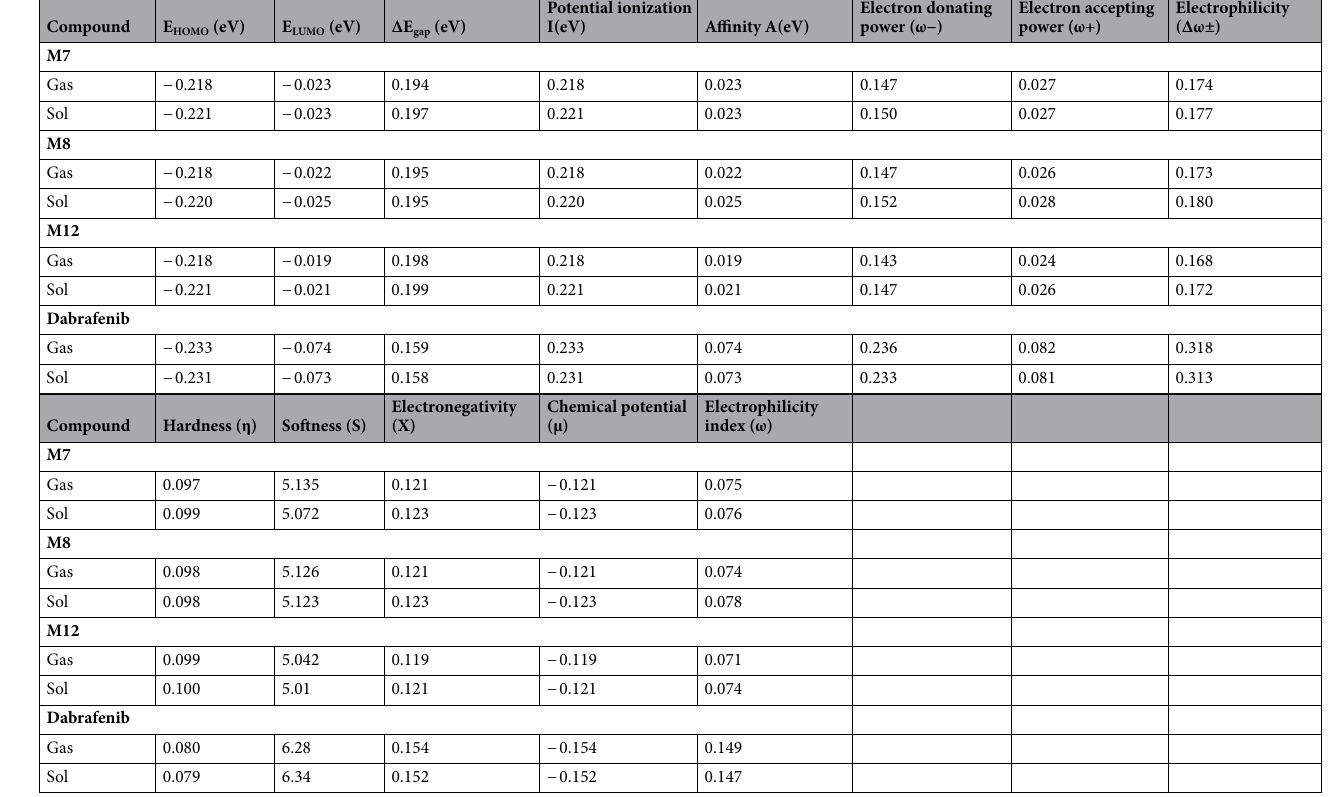
Table 2. Energetic parameters of M7, M8, M12 and Dabrafenib in gas and solvent phase.